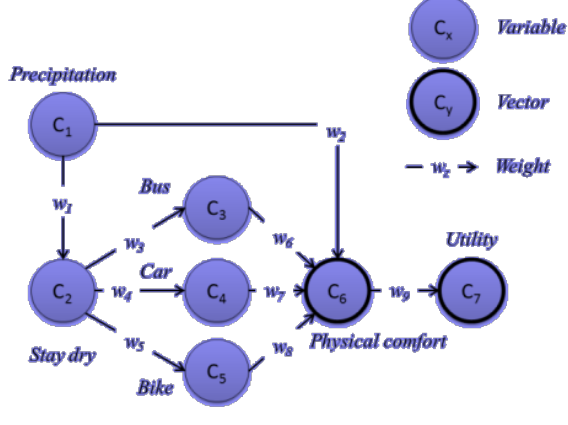
Fig. 4. General topology of a minimum